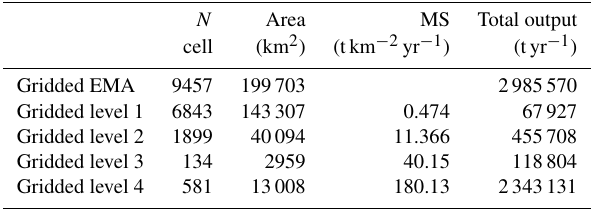
Table A3. Results of microseepage gridding (0.05 ◦ × 0.05 ◦ ) for